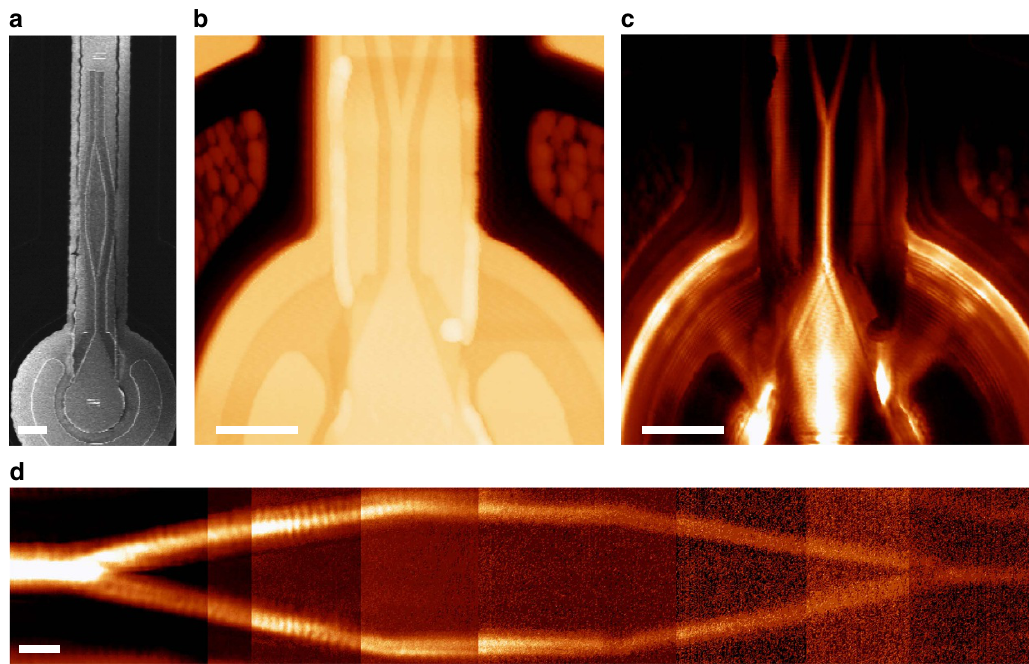
Figure 3 | Mach–Zehnder interferometer integrated on a VCSEL. ( a ) Scanning electron microscope image of an MZI. ( b , c ) Topography and near-field intensity distribution of the coupling and splitting branches of the MZI. ( d ) Near-field intensity distribution in the MZI showing splitting and recombination of the SPP modes. The near-field optical microscope scanning range is smaller than the MZI length, therefore; several images were measured in a sequence and subsequently pasted together. Scale bar, 10 m m in ( a ); Scale bar, 11 m m in ( b ); Scale bar, 11 m m in ( c ); Scale bar, 1.6 m m in ( d